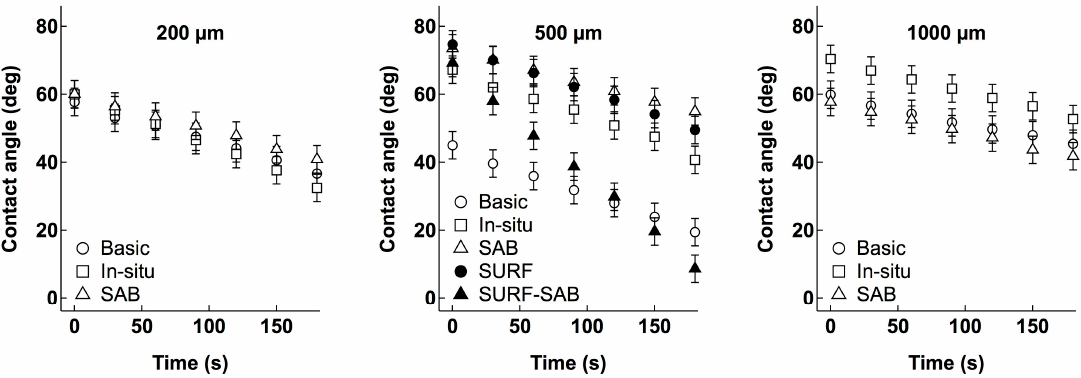
Figure 5. Dynamic contact angles of 200, 500, and 1000 µm CA membranes fabricated by the basic procedure or by in situ addition of salt (in situ) and salt coagulation bath (SAB).